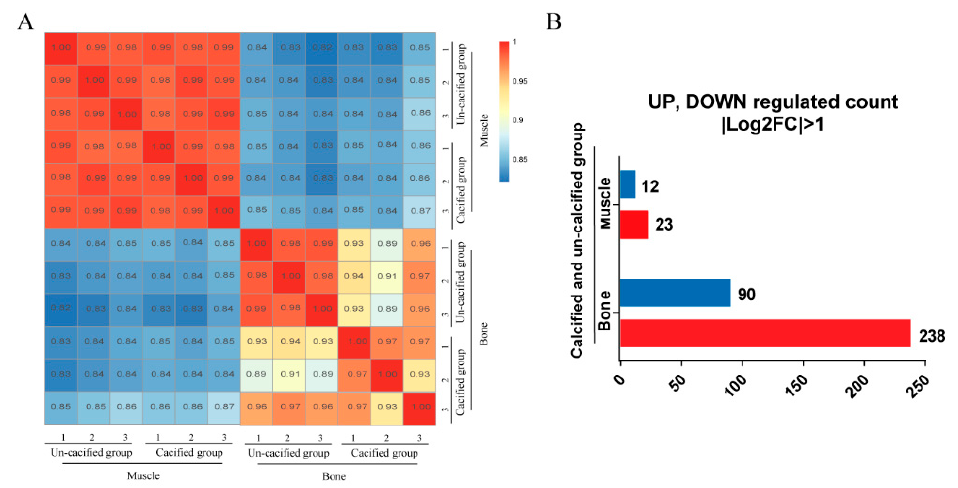
Figure 4. The correlation analysis among samples and the number of differentially expressed genes. ( A ) The correlation analysis among samples based on the differentially expressed genes. The horizontal and vertical coordinates are log10 (FPKM + 1) of the samples compared with each other. ( B ) The differentially expressed genes in the sternum and muscle between the calcified and un-calcified groups are shown as up-regulated or down-regulated, in which red represents up-regulated and blue represents down-regulated.